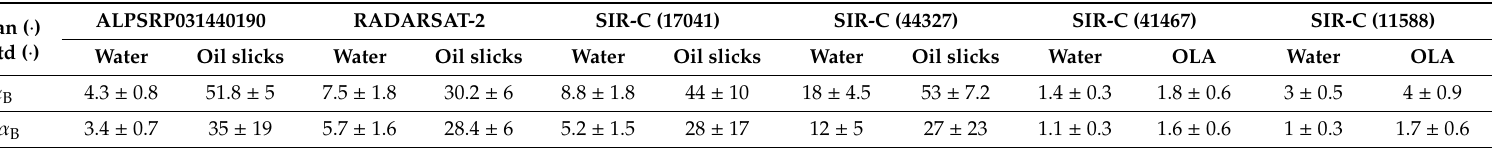
Table 3. α B and ∆ α B values (in degrees) of the other six FP images. Areas outlined in Figure 6 were used for